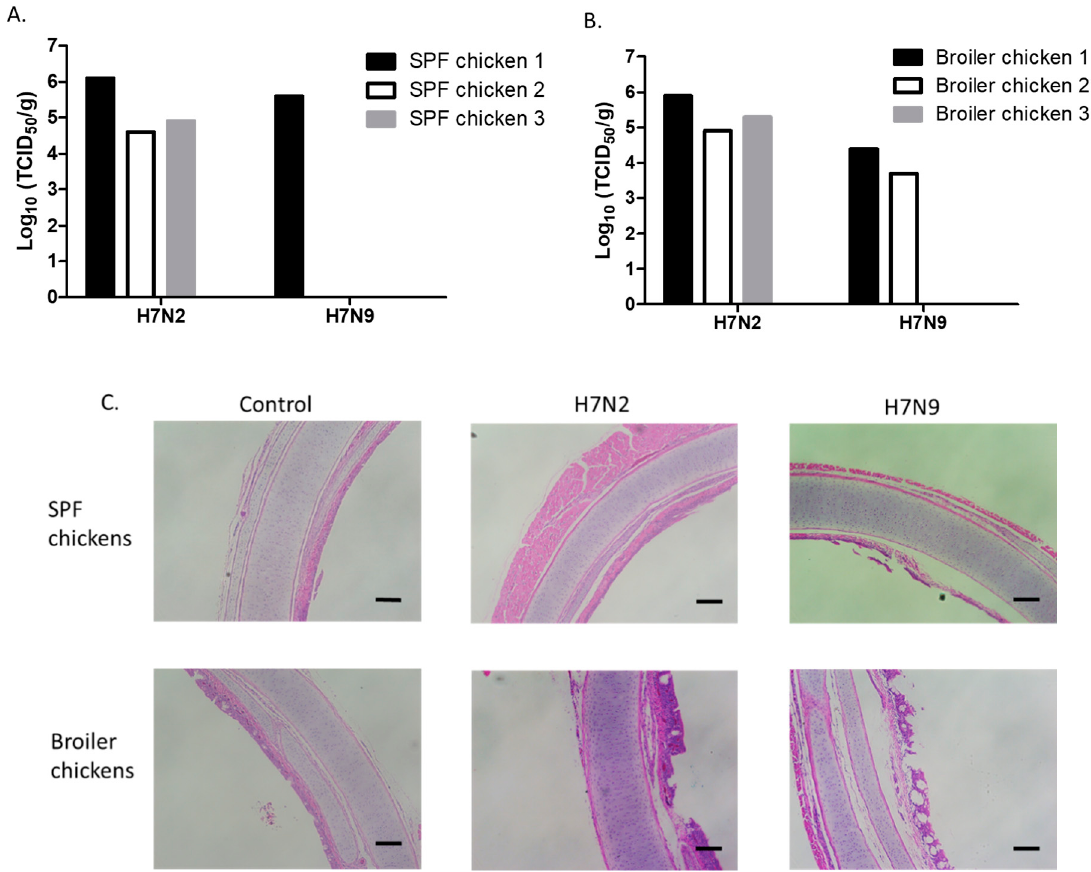
Figure 3. Replication of H7N2 and H7N9 in the trachea of 4-week-old SPF and broiler chickens. Birds were intranasally inoculated with 200 μ L of each virus (10 7 pfu/mL). Trachea samples were collected from SPF ( A ) and broiler ( B ) chickens for virus titration in MDCK cells on days 3 pi. Virus titers were expressed as 50% tissue culture infectious dose (TCID 50 /g). For histopathology, trachea samples were collected from uninfected or infected 4-week-old SPF and broiler chickens ( C ). The samples were fixed in phosphate-buffered formalin, were processed for section, and stained with hematoxylin and eosin (scale bar = 2 mm).